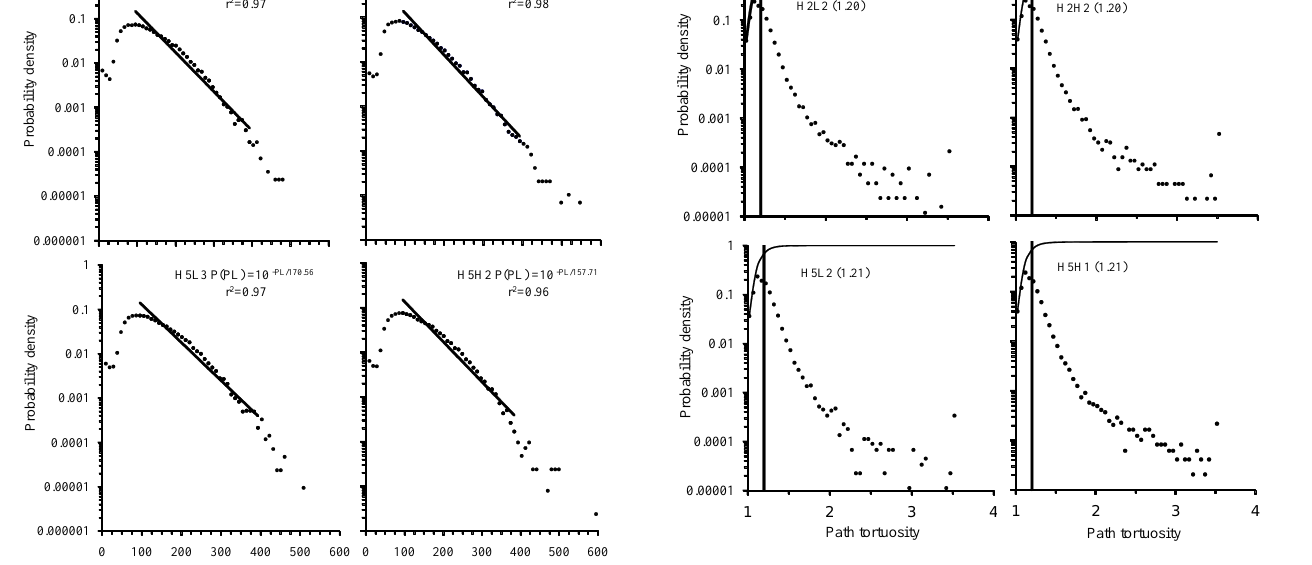
Figure 6. Probability density (solid points) versus path tortuosity and cumulative probability density (solid line) versus path tortu- osity for Hamra 0.5 and 2.0mm aggregate treatments (H0.5 and H2.0) and low- and high-compaction treatments (L and H). Selected replicates are shown in the figure (last number in treatment name is replicate). The vertical line and the number within parentheses is the sample mean